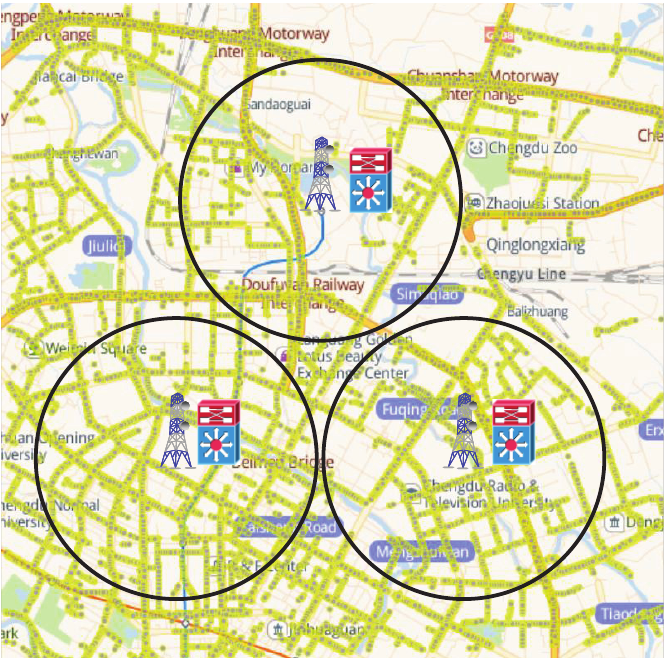
Figure 5. Simulation